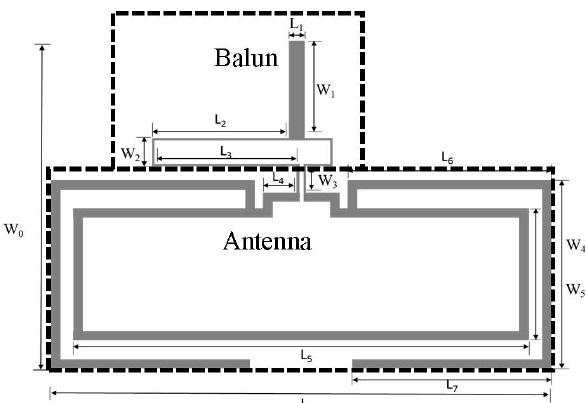
Figure 2. Layout of the proposed antenna fed using a balun. The wide space in the center is left intentionally for sensor integration.